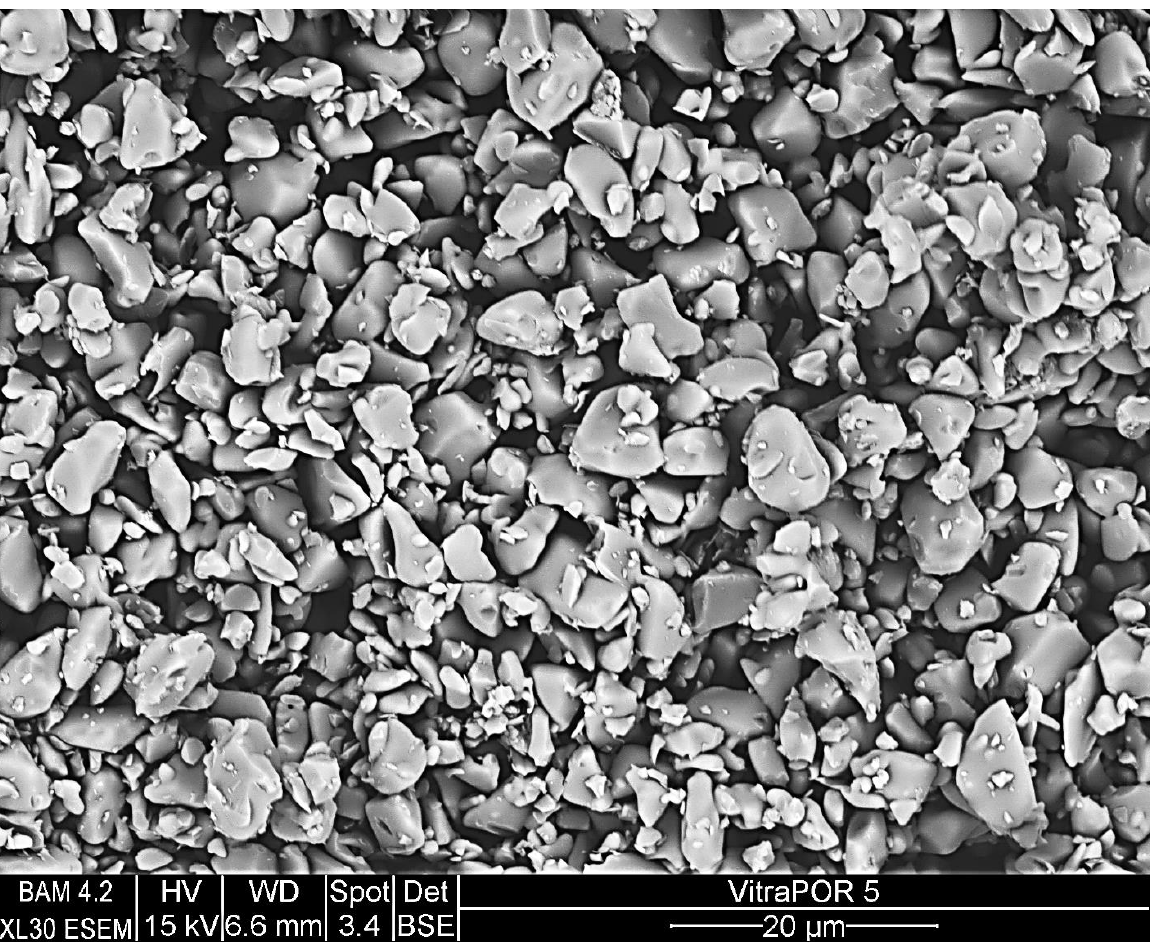
Figure 1. Environmental scanning electron microscopy (ESEM) of a sintered borosilicate monolith (VitraPOR 5).